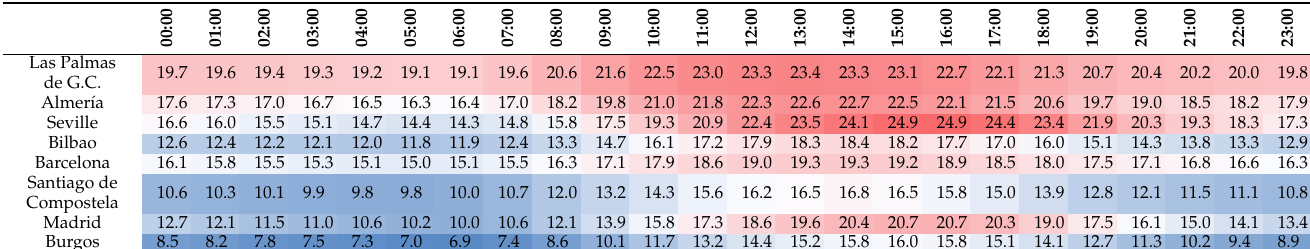
blue = low temperatures, red = high temperatures. It can also be seen how, except for the case of Las Palmas de Gran Canaria, the energy savings provided by the models with a green roof (B-C) are greater when compared to the reference model (without previous insulation in the envelope) than if compared to the energy consumption of these two models with model A (with a thermal envelope’s trans- mittance lower than the limit established by the standard and with fewer air infiltrations).